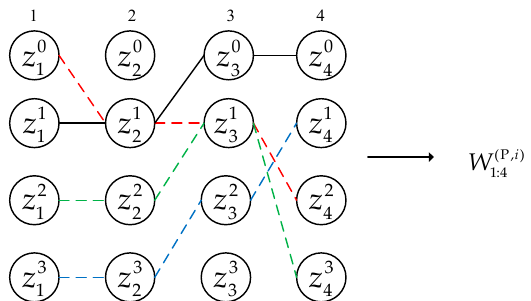
Figure 1. Illustration of the first step. Given a Bernoulli RFS of target i , we can generate the ( P, i ) corresponding set W according to the sensor order, where the measurements in the same column 1:4 are generated from the same sensor. The solid line represents the current best combination, and the dotted line represents other better alternatives.